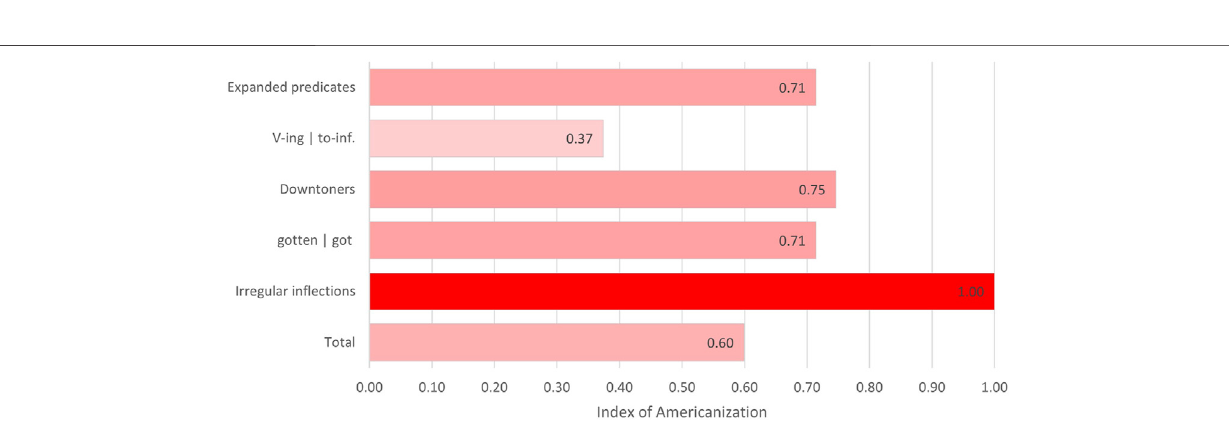
Frontiers in Communication |